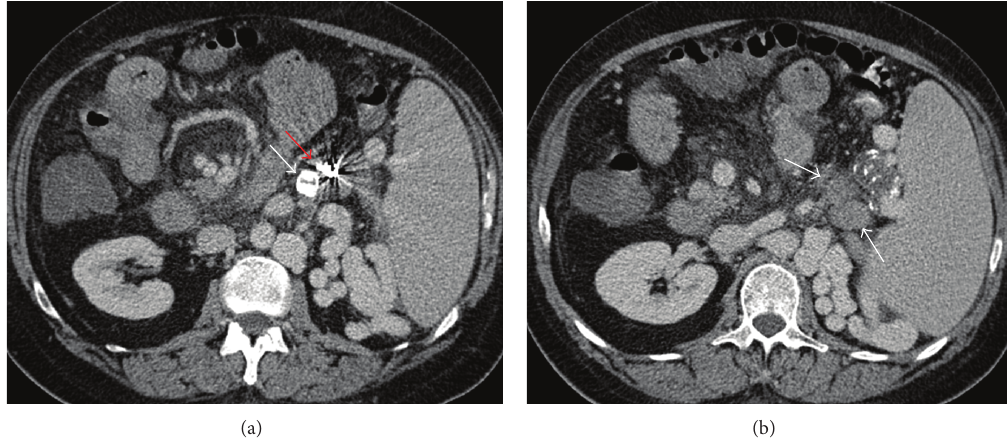
Figure 4: (a) Contrast-enhanced CT on postprocedure day 2 demonstrates Amplatzer vascular plug (white arrow) and coils (red arrow) within a splenorenal shunt. (b) White arrows demonstrate absence of flow distally in embolized splenorenal